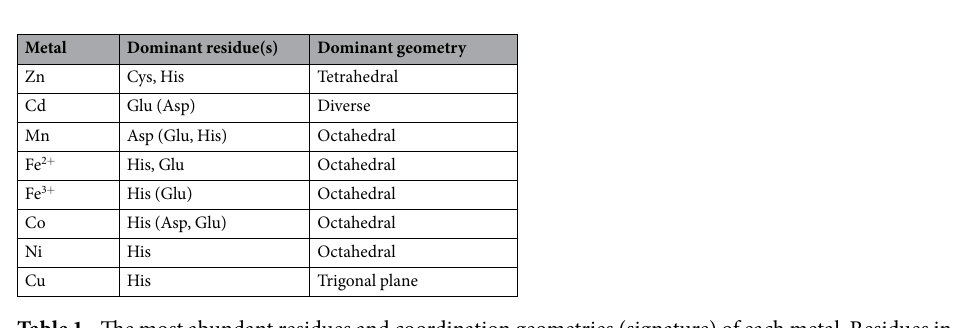
The statistics of the amino acid and coordination number propensities of all examined metals are summarized in Fig. 3 and Fig. 4, respec- tively. For amino acid and coordination number statistics, complete data are provided in Supplementary Table S2. For coordination geometry data, see Supplementary Table S3. As expected from previous studies 3,4,8–12 , most metals are frequently bound by His, Asp and Glu residues and present an octahedral coordination geometry. Zn and Cu, however, present quite different preferences. While Zn has a high tendency to bind Cys with tetrahedral coordination, Cu binds almost exclusively to His, usually with trigonal coordination. Cd shows no statistically